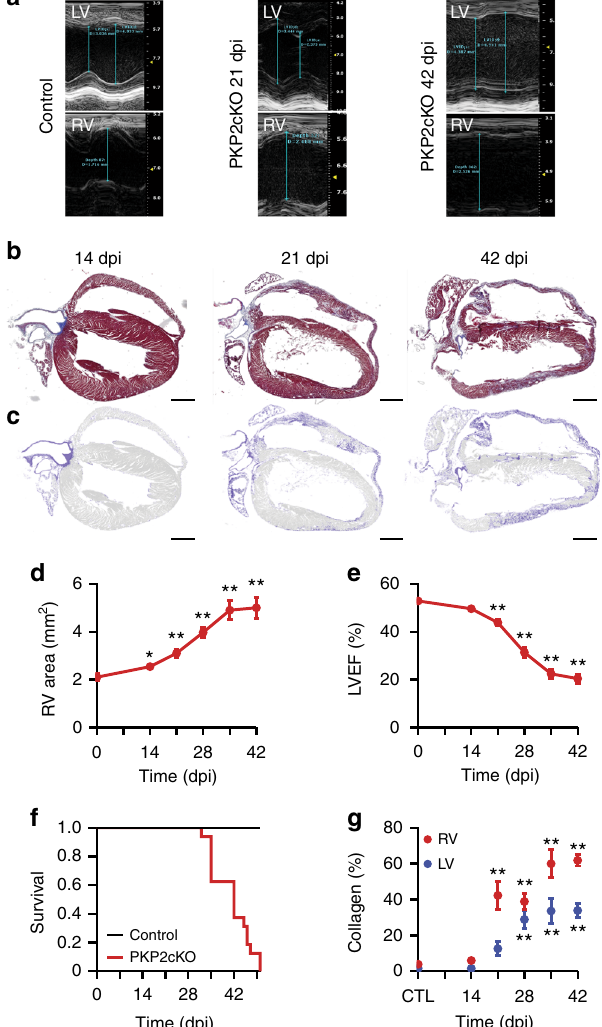
Fig. 1 Progression of cardiomyopathy in PKP2-cKO mice. a Representative images of M-mode echocardiography recorded from left ventricle and right ventricle (LV; RV) of PKP2-cKO mice before (control; left ), 21 dpi ( middle ) and 42 dpi ( right ). Notice scales on the right of each panel. b Masson ’ s trichrome staining of longitudinal heart sections of PKP2-cKO hearts at 14, 21, and 42 dpi (left, middle and right panels, respectively). c High contrast mask of the same sections emphasizing collagen deposition in the RV and LV in blue . Scale bar = 1 mm for all images. d Time course of change in RV area (measured by modi fi ed long axis B-mode echocardiography) in PKP2- cKO mice as a function of days after tamoxifen injection (dpi). Number of animals: n = 21 (0 dpi); n = 12 (14 dpi); n = 18 (21 dpi), n = 16 (28 dpi); n = 11 (35 dpi); n = 9 (42 dpi). e LV ejection fraction (LVEF) in PKP2-cKO, measured by long axis B-mode echocardiography. Number of animals: n = 21 (0 dpi), n = 13 (14 dpi), n = 19 (21 dpi), n = 16 (28 dpi), n = 15 (35 dpi), and n = 10 (42 dpi). For d , e , we obtained repeated measures from the same animals; statistical signi fi cance was calculated by paired Student ’ s t -test, comparing each value against its own control. f Kaplan – Meier survival curve of PKP2-cKO and control mice as a function of days after tamoxifen injection. A total of 16 PKP2-cKO and 10 control animals were followed. g Quanti fi cation of collagen deposition in the right (RV, red dots ) and in the left (LV, blue dots ) ventricle of control (CTL, n = 7) and PKP2- cKO hearts at 14 dpi ( n = 5), 21 dpi ( n = 10), 28 dpi ( n = 8), 35 dpi ( n = 8) and 42 dpi ( n = 9). Statistical signi fi cance by one way ANOVA, RV and LV compared independently against corresponding control. For d , e , g : * p < 0.05, ** p <